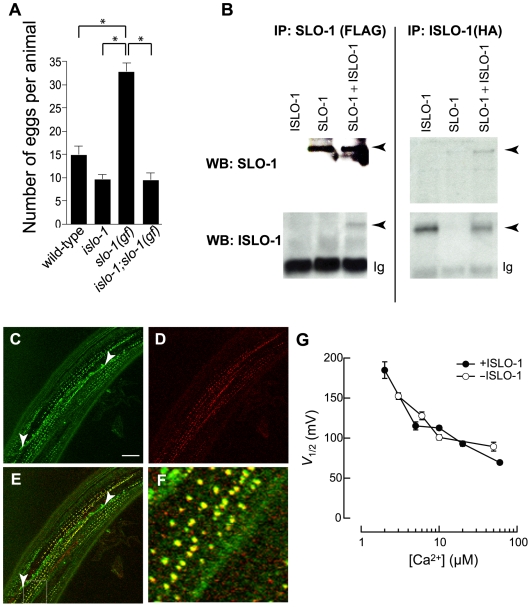
ISLO-1 represents a novel subunit of SLO-1 channel.(A) The number of eggs retained in uteri was counted for each of the indicated mutants 30 hrs after the L4 stage. Error bars, SEM. Asterisks represent significant difference from each other (P<0.0001) (B) Co-immunoprecipitation of SLO-1 and ISLO-154-end. SLO-1 and ISLO-154-end are tagged with FLAG and HA epitope at the N-termini, respectively. Immunoprecipitations and western blot analysis were performed as Figure 3A. Black arrowheads represent specific bands. Ig, immunoglobulin light chain. (C–F) Integrated transgenes of a GFP-tagged slo-1 (C) and a mCherry-tagged islo-1 (D) are shown in the islo-1;slo-1 double mutant. White arrowheads denote the neuronal processes where co-localization is not observed. (E) Merged image of (C,D). (F) Enlarged image of inset in E. (G) V
1/2 as a function of [Ca2+]i was derived from macroscopic G-V curves (not shown). Filled (n = 3) and open circles (n = 5) are the average values in the presence and absence of ISLO-1, respectively. Some SEM error bars are smaller than the symbols.